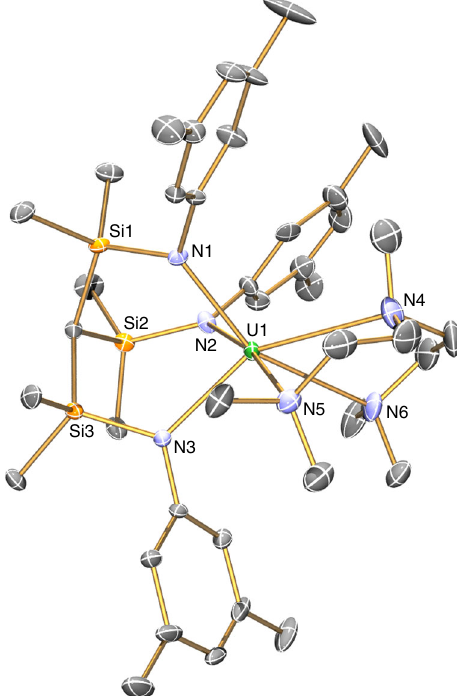
Fig. 4 Molecular structure of [U(Ts Xy )(pmdeta)] ( 2 .pmdeta) at 120 K with 40% probability ellipsoids. Hydrogen atoms and minor disorder components are omitted for clarity. Selected distances: 2 .pmdeta - U1-N1 2.373(5), U1-N2 2.394(6), U1-N3 2.355(5), U1-N4 2.831(7), U1-N5 2.866